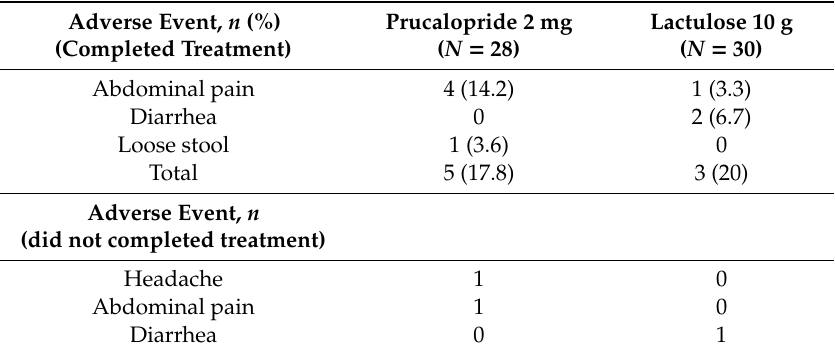
Table 5. Treatment emergent adverse events.